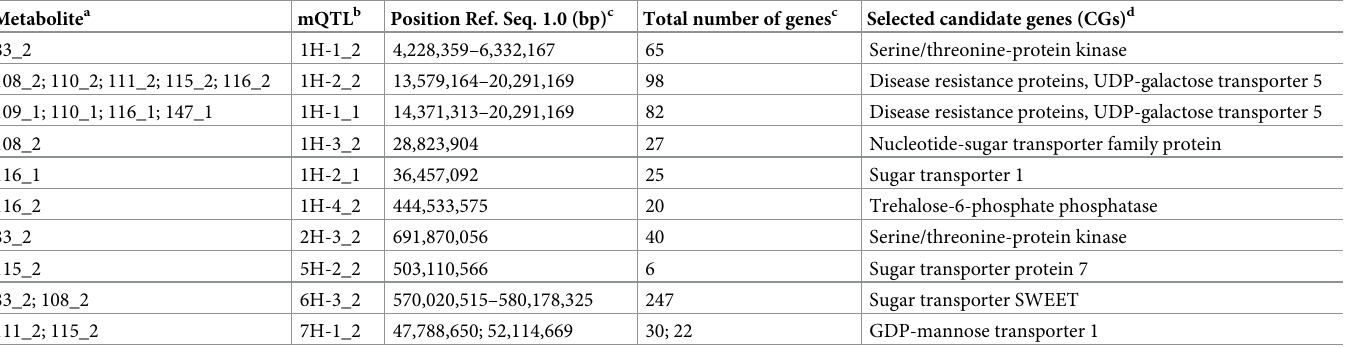
Fig 3. Manhattan plot of all metabolites of the second sampling date. All metabolites showed significant marker-metabolite associations on chromosome 1H. The different point shapes and point colours differentiate the metabolites and the associated SNPs. The x-axis shows the chromosomes with SNP ordering based on the Morex Reference Sequence 1.0 [49], the detection rate (DR) is given on the y-axis. The dashed line indicates the threshold of DR > 25, which was used as significance threshold. https://doi.org/10.1371/journal.pone.0246510.g003 Table 2. List of selected mQTL and sugar-related candidate